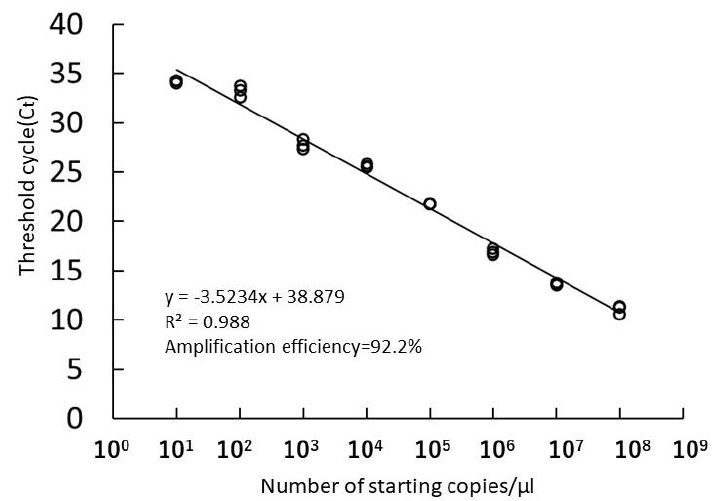
Figure 3. Calibration curve for the absolute quantification of Serpula himantioides based on real-time PCR with SYBR-Green as the fluorescent dye. The threshold number of PCR cycles (Ct-value) was plotted against the log of the initial quantity of template DNA ( n = 3). Amplification efficiency was calculated using the Applied Biosystems™ Analysis Software (version 1.0.1).